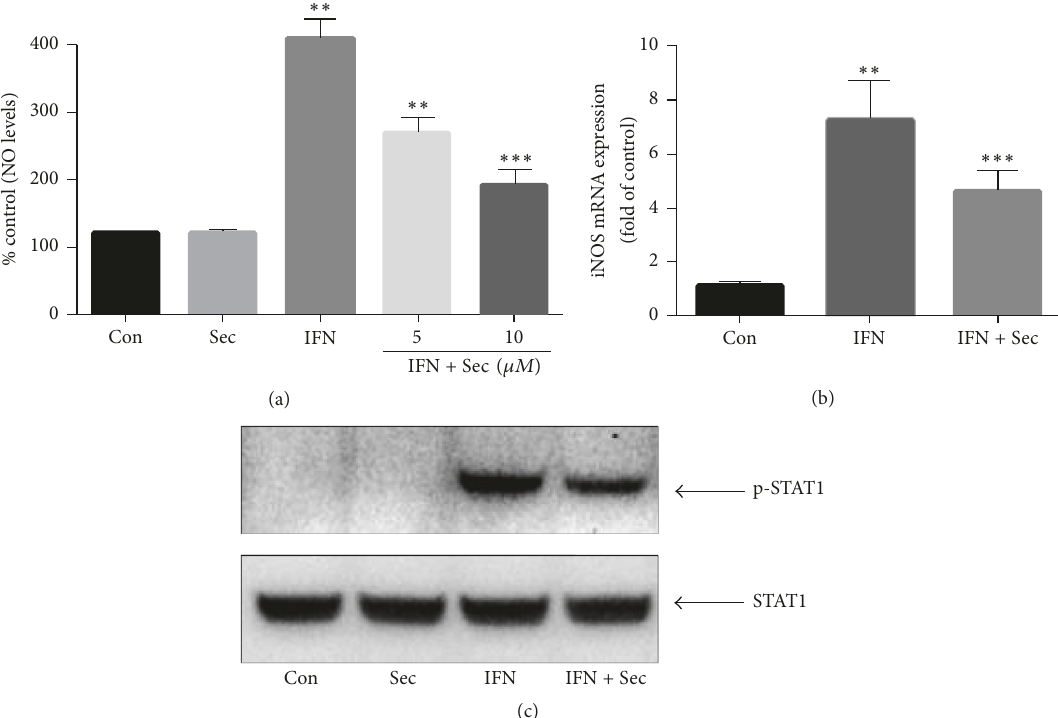
Figure 6: Securinine pretreatment reduces IFN- 𝛾 -induced NO production, iNOS mRNA expression, and phosphorylation of STAT1 𝛼 in BV2 microglia. BV2 microglial cells were pretreated with securinine for 1h and then challenged with IFN- 𝛾 (50U/mL) for 24 h (a), 6 h (b), or 30 min (c). The expression levels of nitric oxide, iNOS mRNA, and tyrosine phosphorylation of STAT1 𝛼 were determined by Griess Reagent assay (a), real-time PCR analysis (b), or Western blotting (c), respectively. The data are expressed as mean ± SD, 𝑛 = 4 . ∗∗ 𝑃 < 0.01 significantly different from control samples. ∗∗∗ 𝑃 < 0.05 , significantly different from the LPS-treated